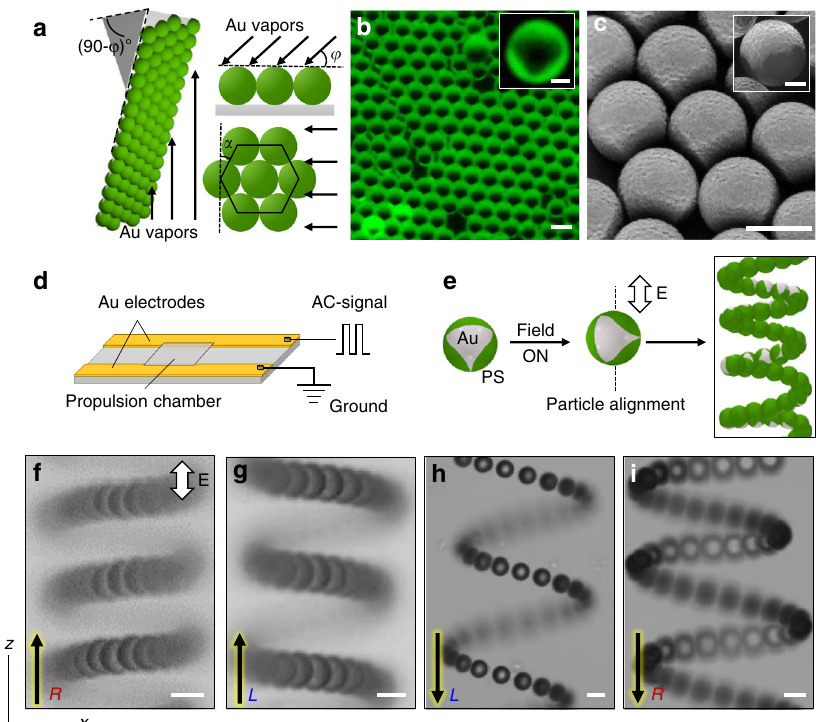
Fig. 1 Particle fabrication and principle of directing dynamics of patchy colloids. a A schematic of glancing angle deposition of metal (gold, Au) vapors onto a substrate coated with monolayer of polystyrene (PS) microspheres. The arrows represent the direction of incident metal vapors. The shape of the metal patch depends on the orientation of the deposition vector relative to the particle monolayer as characterized by the angles φ and α . Triangular patches with (approximate) mirror symmetry are obtained when α = 0. b Fluorescence and c scanning electron micrographs of polystyrene microspheres (green in b and dark gray in c ) with a triangular shaped gold patch (dark in b and light gray in c ). d A schematic of the experimental setup with coplanar gold electrodes. Particle motion in the AC-electric fi eld is monitored by an upright light microscope in the direction normal to the plane containing the electrodes. e Schematic showing the initial alignment of the particle upon turning on the external AC-electric fi eld. The particle aligns with in the applied fi eld E (Supplementary Fig. 4) and performs helical motion. f – i Superimposed bright- fi eld micrographs of patchy particles migrating along the fi eld axis in four distinct helical trajectories. The applied fi eld strength in the experiments is 250 V cm − 1 at a frequency of 10 kHz. The arrows represent the direction of linear motion of the helically propelled patchy colloids; R and L denote right and left-handed helical trajectories. The scale bars in b , c , and f – i are 5 µ m, and in inset b , c are 1 µ